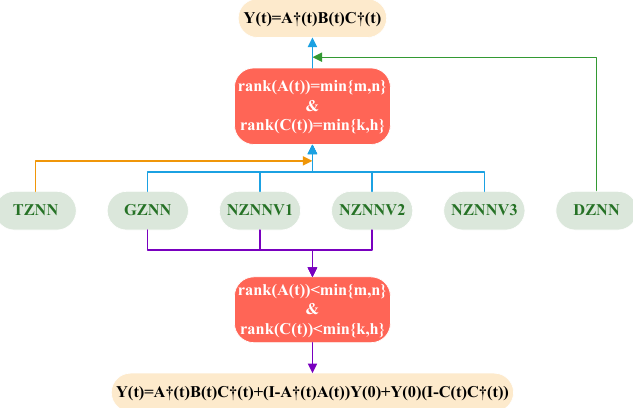
Figure 1. Solutions produced by proposed ZNN